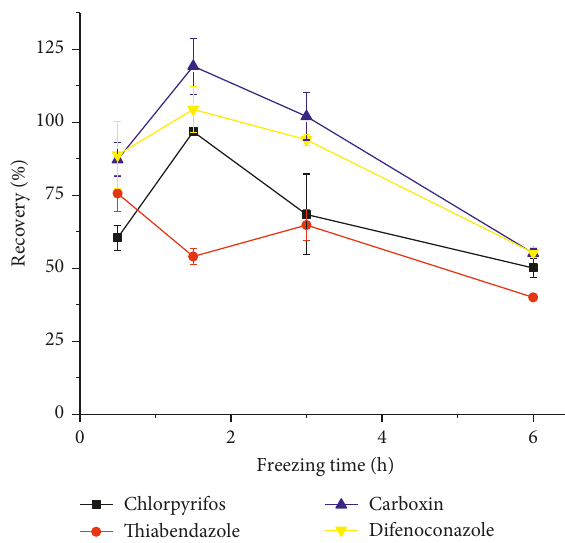
Figure 4: Pesticide residue recoveries in caj´a-manga by the SLE- LTP method after different freezing times of samples.